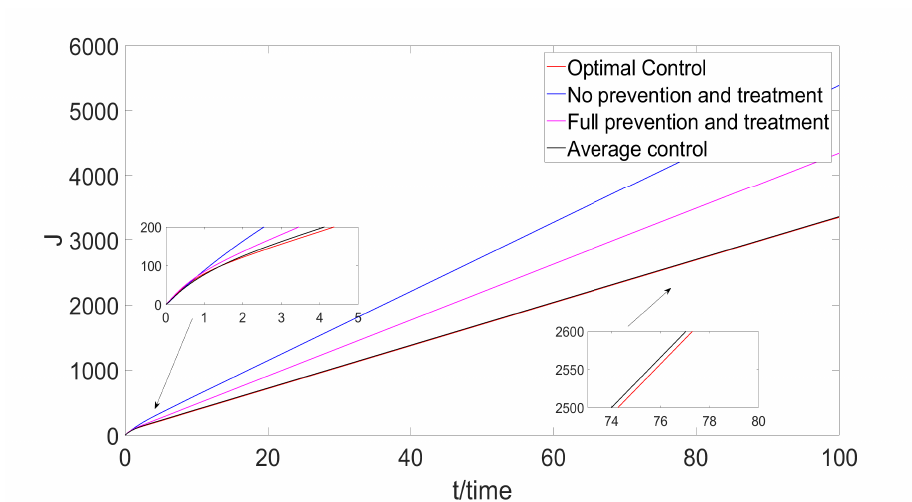
Figure 7. The cost